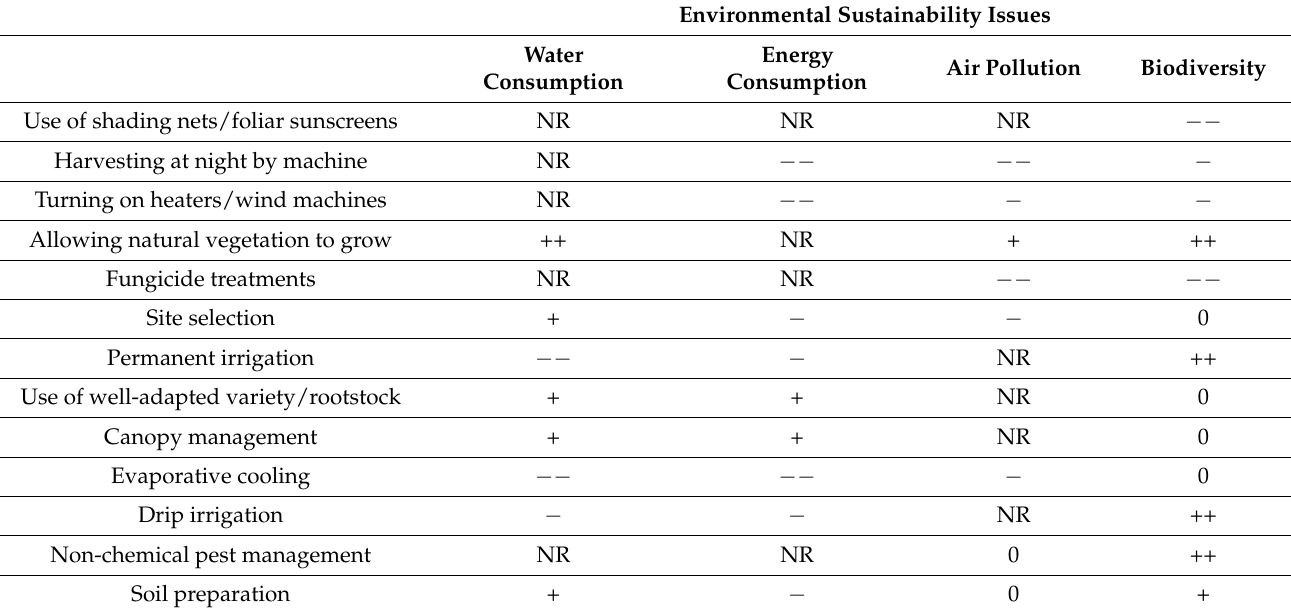
Table 3. Path dependencies of the selected adaptation